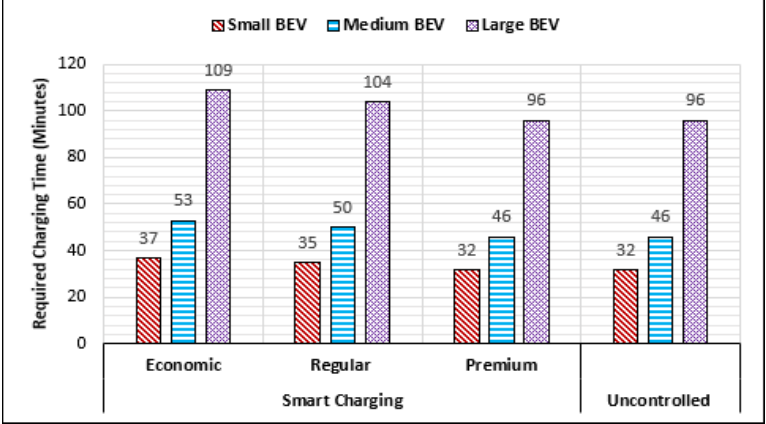
Figure 18. Charging Duration to Increase Battery SOC from 20% to 80% using the smart and uncontrolled charging.